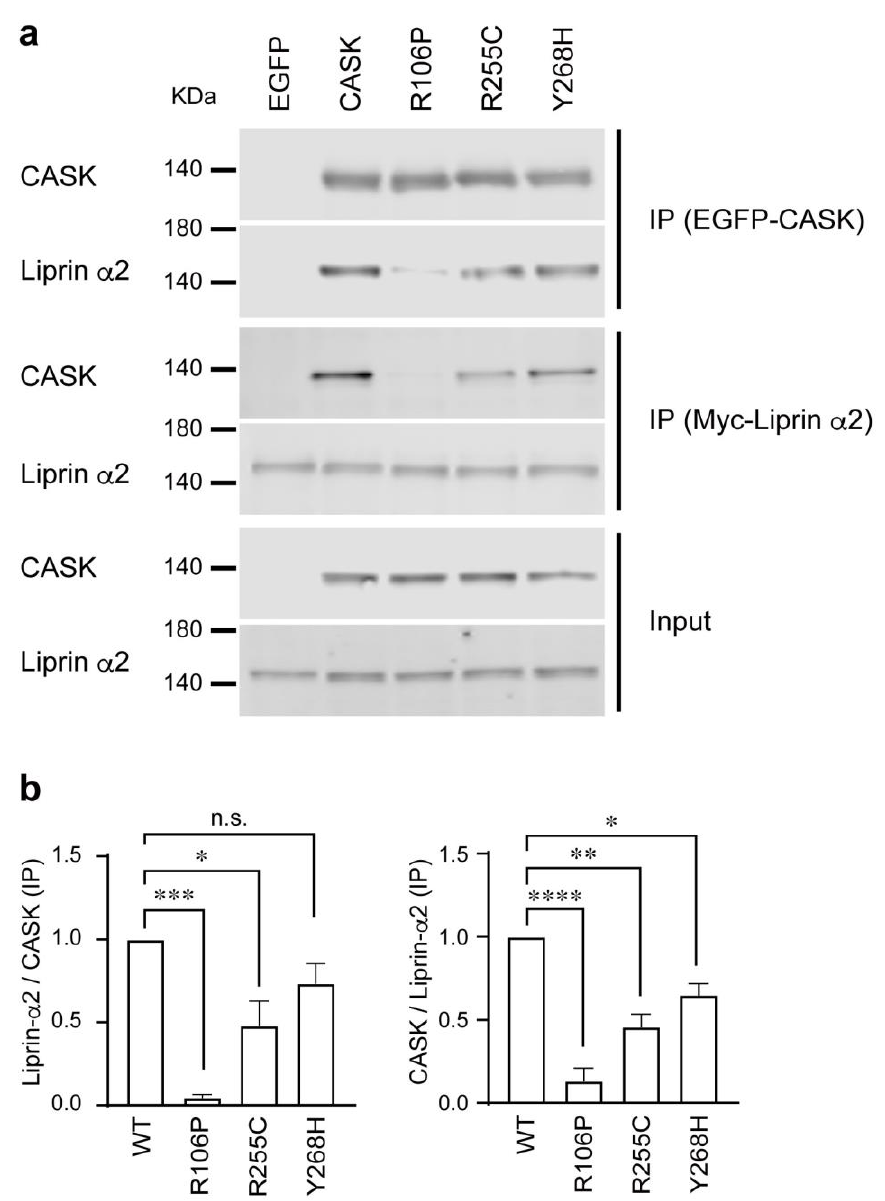
Figure 8. Deleterious mutations affect CASK-Liprin- α 2 interaction. ( a ) Western blotting images for immunoprecipitation for analyzing binding affinity between CASK mutants and Liprin- α 2. HEK293T cells were co-transfected with EGFP alone, EGFP fused wild-type or mutant CASK harboring either R106P, E255C, or Y268H mutations and Myc-tagged Liprin-α2 constructs. Cell lysates were immunoprecipitated with anti-GFP (IP EGFP-CASK) or anti-Myc antibody conjugated beads (IP Myc-Liprin). Input and immunoprecipitated proteins were subjected to Western blotting using anti-CASK or anti-Myc antibodies for measurement of binding affinity. ( b ) Binding affinity between Liprin- α 2 and CASK missense mutants was measured by the co-precipitation efficiency. ( Left ) Summary graph for affinity measurement by immunoprecipitation with anti-EGFP antibody conjugated beads blotted with anti-Liprin antibody. The signal intensity was normalized by the one co-transfected with wild-type CASK. ( Right ) Summary graph for affinity measurement by immunoprecipitation with anti-Myc antibody conjugated beads blotted with anti-CASK antibody. The signal intensity was normalized by the one co-transfected with wild-type CASK. Coimmunoprecipitation experiments were repeated three times. * p < 0.05, ** p < 0.01, *** p < 0.001, **** p < 0.0001; one-way ANOVA, n.s. = not significant.